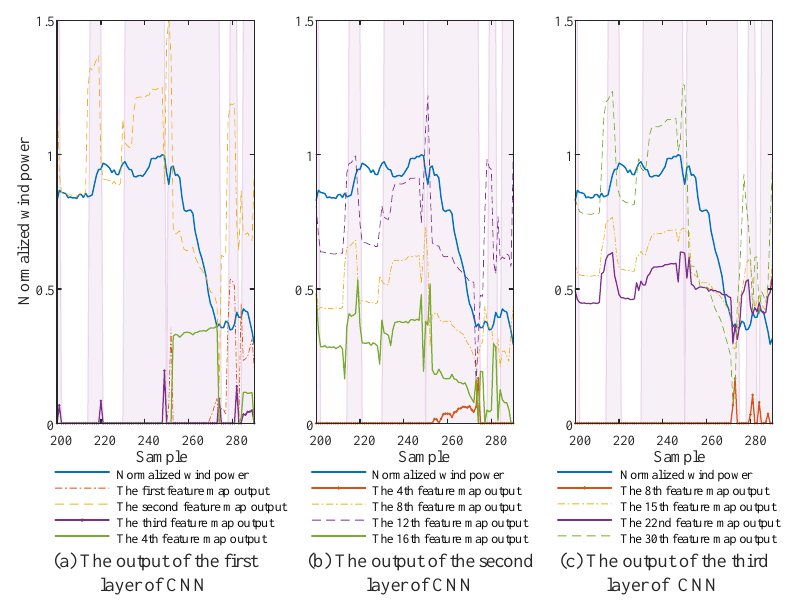
Figure 8. Output of convolutional layers.